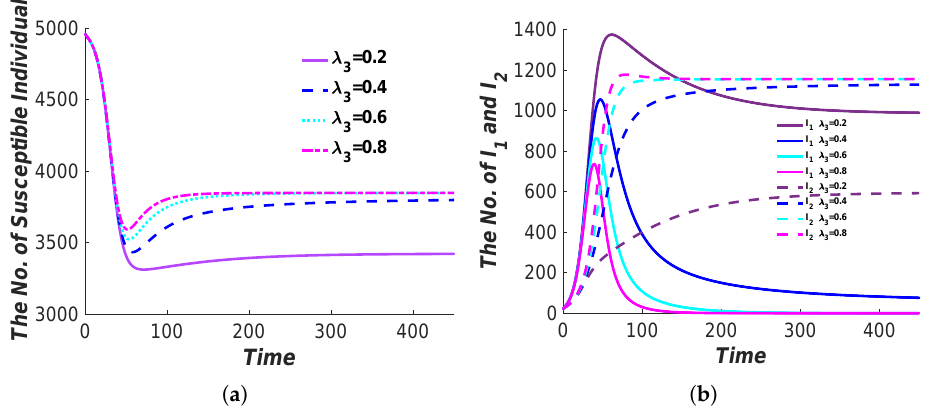
Figure 6. Super-infection case with 1 < R 02 < R 01 . Here, λ 1 = 0.31, λ 2 = 0.3, γ 1 = 0.45, γ 2 = 0.5. ( a ) Time evolution of the number of S for various values of the parameter λ 3 . ( b ) Time evolution of the number of I 1 , I 2 for various values of the parameter λ 3 .